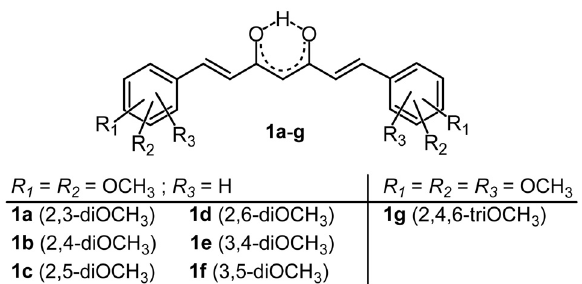
Figure 1. Di- and trimethoxy